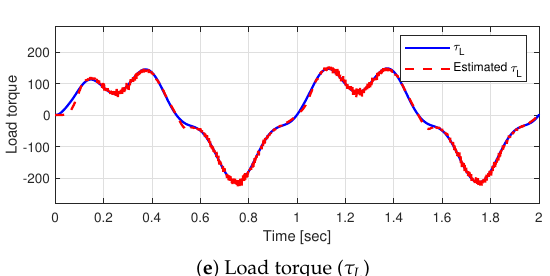
) ( a ), position tracking 1